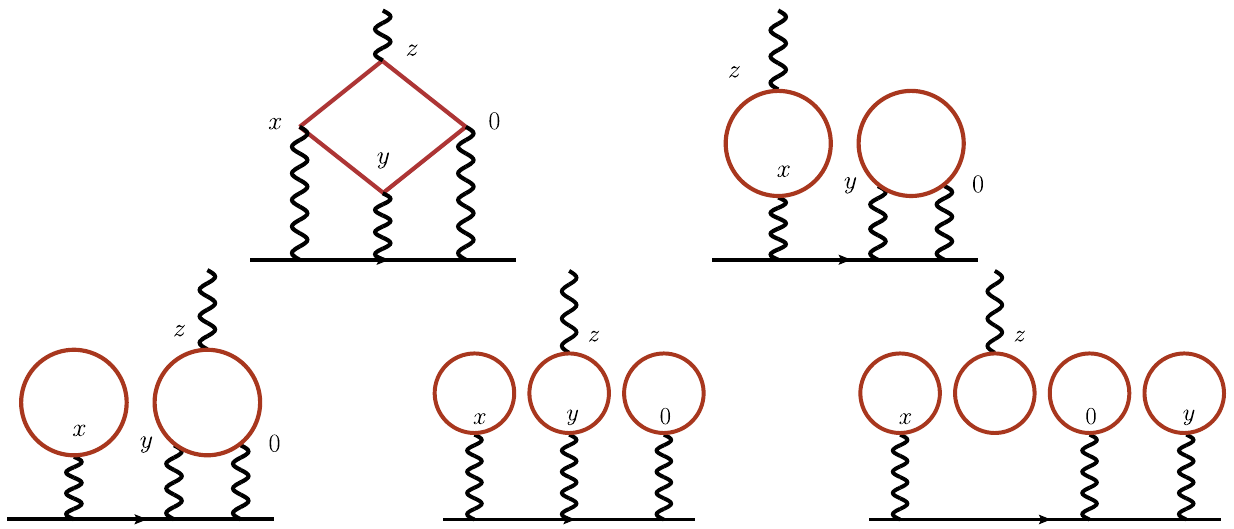
tractions listed in that table. The two diagrams in the first line are the dominant ones and the other three vanish in the SU ( 3 ) f limit